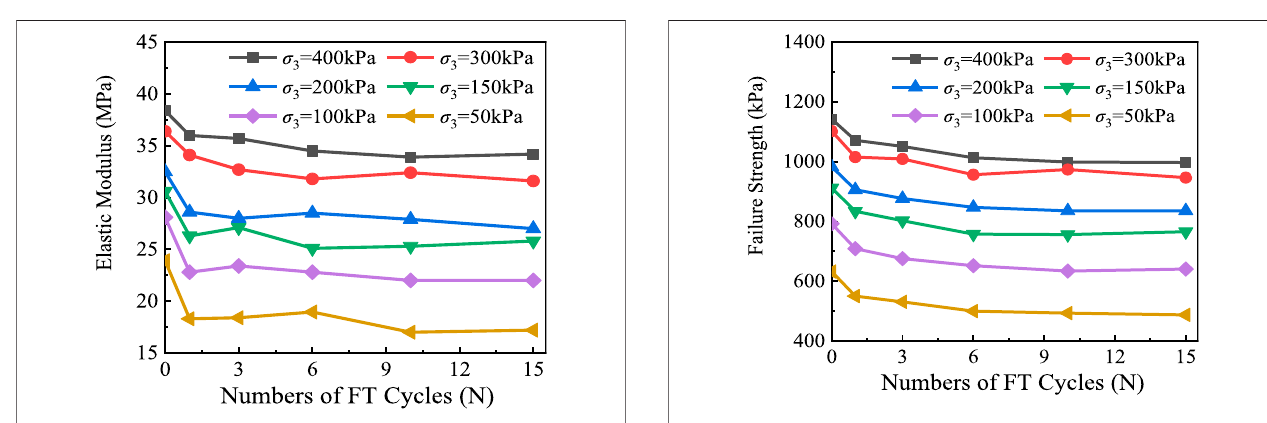
FIGURE 4 | Elastic modulus under various con fi ning pressures and FT cycles.